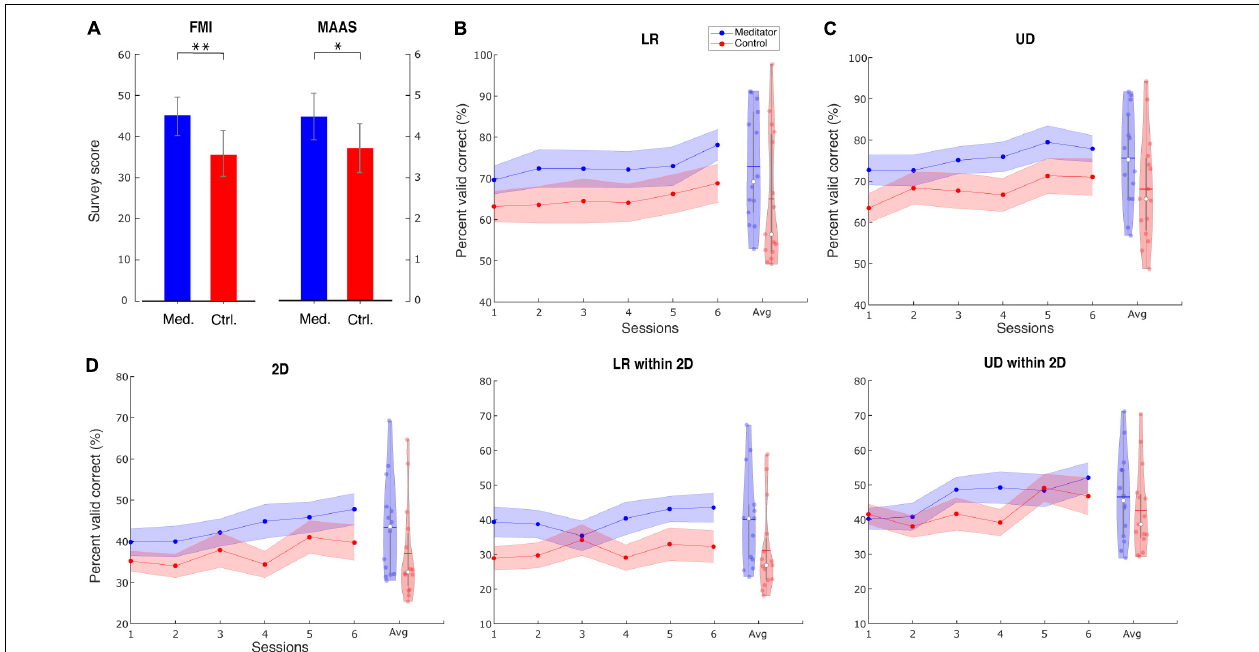
FIGURE 2 | Survey results and group averaged performance and learning. (A) Survey results of FMI and MAAS show that meditators have a higher level of mindfulness than controls. Data are shown as mean ± SD . Med. is meditator, Ctrl. is control. (B) Line plot describes the group LR averaged PVC ± SEM for mediators and controls. Violin plot describes session-averaged performance distribution, with blue horizontal line indicating mean and white dot indicating median. (C) For UD task, (D) for 2D task, LR within the 2D task, and 2D within the 2D task. ∗ Indicates group difference with p < 0 . 05, and ∗∗ indicates p < 0 . 01, same for subsequent